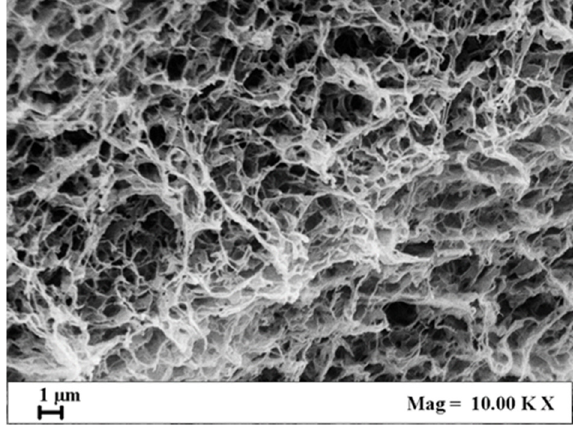
Figure 1. SEM image of 15PVDF-coHFP membrane section.